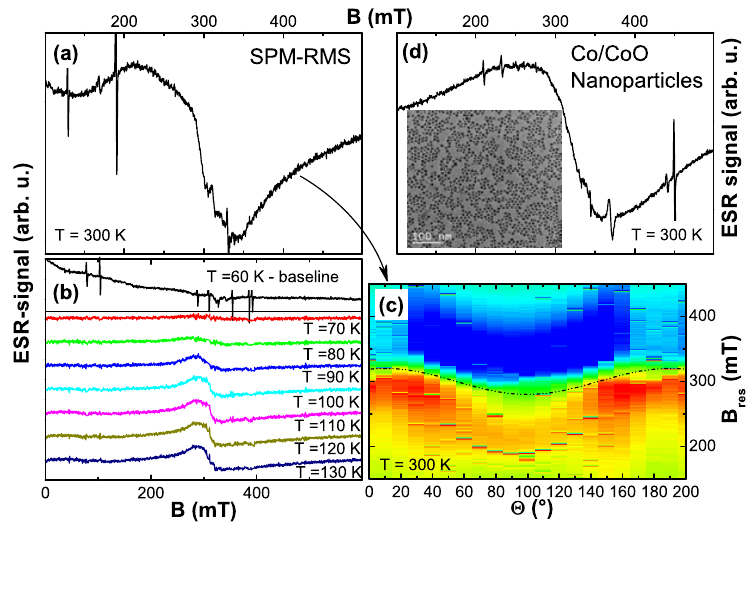
Figure 15. (a) EPR spectrum of the SPM-RMS sample recorded at 300 K. (b) shows the disappearance of the broad resonance line with decreasing temperature and (c) the polar angular dependence at 300 K as color contour plot revealing a weak uniaxial angular dependence (dash-dotted line). For comparison (d) displays the EPR spectrum of Co/CoO nanoparticles (inset: TEM image) recorded under identical conditions as